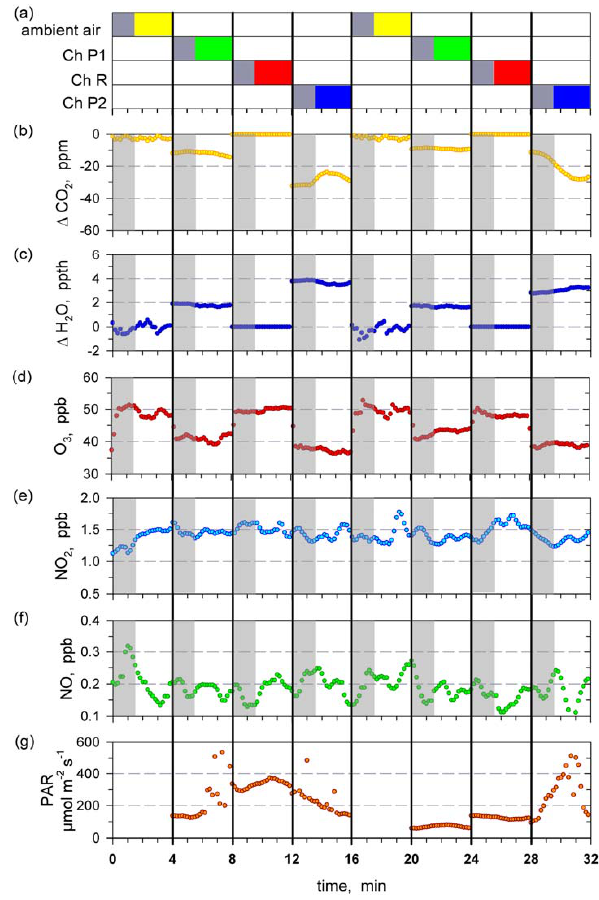
Figure 12. Switching scheme and time series of trace gas mixing ratios over two full 2 Fig. 12. Switching scheme and time series of trace gas mixing ra- measurement cycles during EGER field experiment. Data were corrected for calibration 3 tios over two full measurement cycles during EGER field experi- ment. Data were corrected for calibration factors, temperature de- factors, temperature dependency and offset of analyzers. (a) Control scheme indicating 4 pendency and offset of analyzers. (a) Control scheme indicating periods of skipped data (first 90 s) for data processing (grey bars), sampling/analysis of 5 periods of skipped data (first 90s) for data processing (grey bars), ambient air (yellow bars), sampling/analysis of plant chamber 1 (green bars), 6 sampling/analysis of ambient air (yellow bars), sampling/analysis of plant chamber 1 (green bars), sampling/analysis of reference sampling/analysis of reference chamber (red bars) and sampling/analysis of plant chamber 2 7 chamber (red bars) and sampling/analysis of plant chamber 2 (blue (blue bars). (b-c) Time series of CO 2 and H 2 O mixing ratios measured as difference between 8 bars). (b–c) Time series of CO 2 and H 2 O mixing ratios measured reference chamber and respectively switched intake. (d-f) Time series of O 3 , NO 2 and NO 9 as difference between reference chamber and respectively switched mixing ratios. (g) Photosynthetic active radiation (PAR). 10 intake. (d–f) Time series of O 3 , NO 2 and NO mixing ratios. (g) Pho- tosynthetic active radiation (PAR).